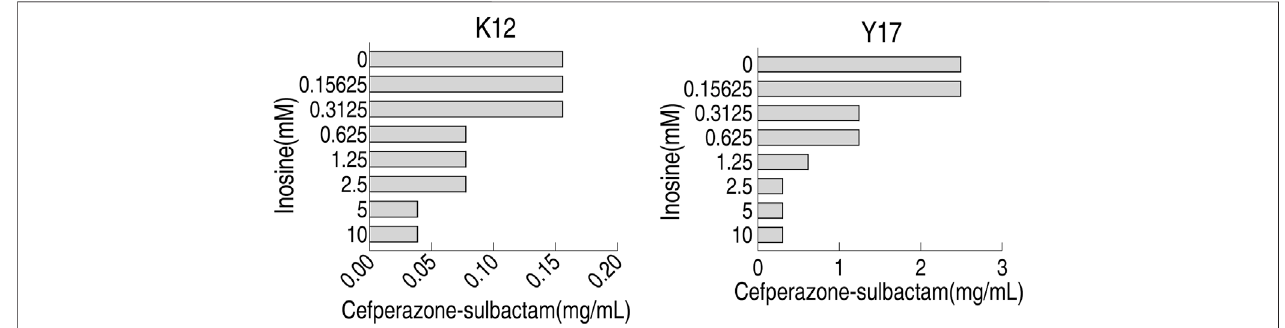
FIGURE 4 | MKC of K12 and Y17 in different inosine concentration by SCF.